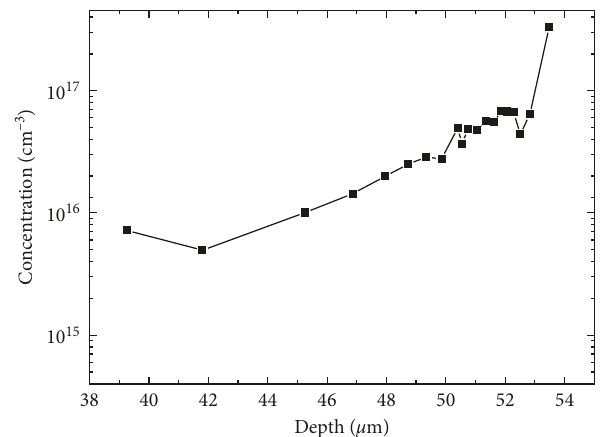
Figure 6: Distribution of current carrier concentration on the boundary between i - and n -regions of diode defined by C - V measurements at